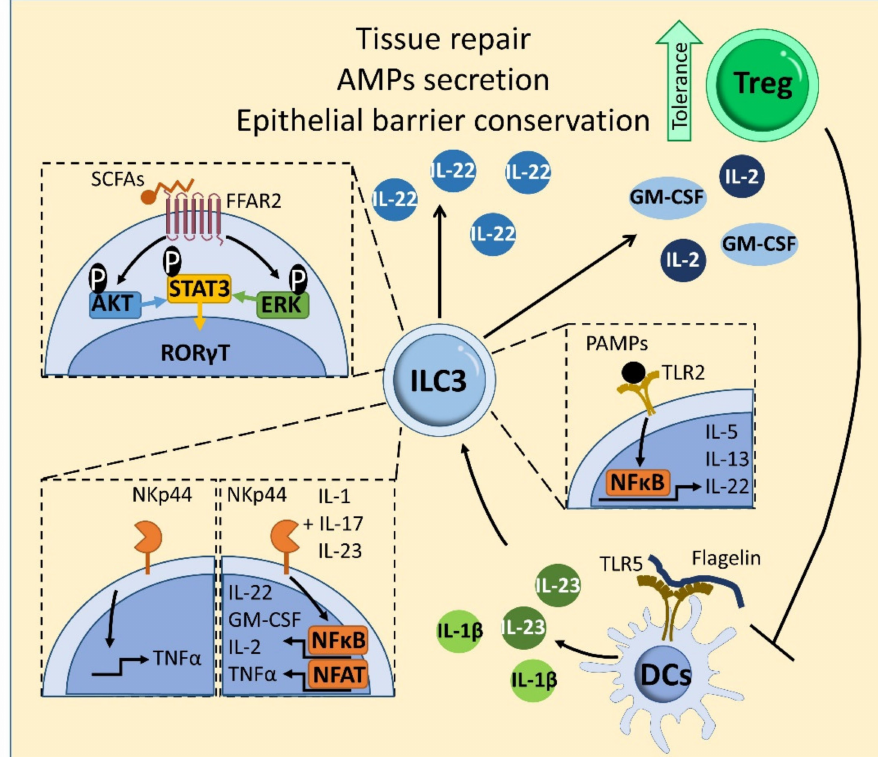
Figure 6. Microbiota-ILC3 interactions in intestinal homeostasis. Some SCFAs are recognized by the receptor FFAR2 on ILC3s, triggering IL-22 cytokine production by stimulating the AKT–STAT3 and ERK–STAT3 signaling pathways. TLR2 stimulation in human ILC3s promotes the production of IL-22, IL-13 and IL-5 upon activation of signaling via NF- κ B and JAK (not shown). Stimulation of the TLR5receptor on dendritic cells (DCs) with the bacterial protein flagellin promotes the production of IL-23 and IL-1b, which induces production of IL-22, and IL-2 and GM-CSF by ILC3s, respectively. In human ILC3s, ligation of the natural cytotoxicity receptor NKp44 promotes the production of TNF α by ILC3s and, in combination with IL-1, IL-17 and IL-23, enhances ILC3 production of IL-22, GM-CSF, IL-2 and TNF α in a mechanism mediated by NF- κ B and Nuclear factor of activated T-cells (NFAT) signaling. NKp44 receptor activation also increases the proportion of IL-22-producing ILC3s. IL-22 facilitates intestinal homeostasis by preservation of epithelial barrier function and promoting the secretion of antibacterial peptides (AMPs). IL-2 and GM-CSF contributes to intestinal tolerance mediated by Tregs. Tregs prevent ILC3-associated colitis by inhibiting IL-23- and IL-1 β -induced IL-22